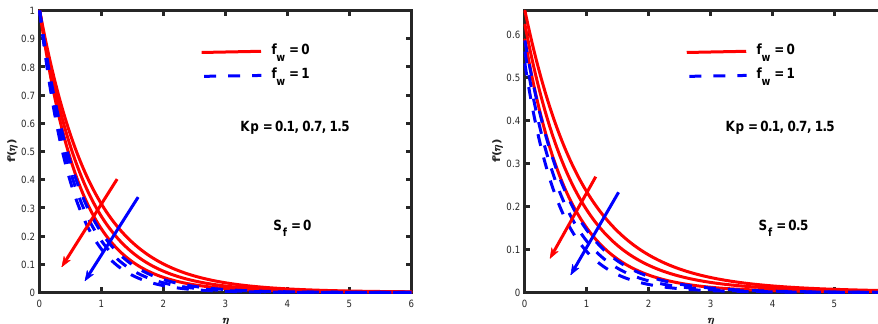
the flow regime declines. In Figure 5, the effect of Rayleigh number Rb and f w is discussed on the velocity profile. Due to this effect velocity profile shows a decrement under the action of hydrodynamic slip S f . Physically, the decrement occurs because buoyancy force produces resistance against the movement in the horizontal direction.